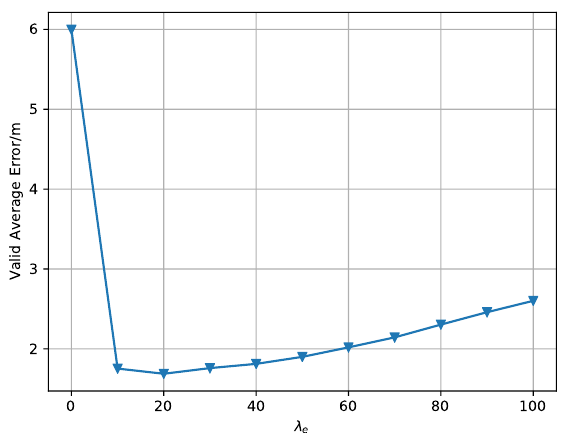
Figure 11. Validation error when taking different super parameters in the 12th month (Sinkhorn).